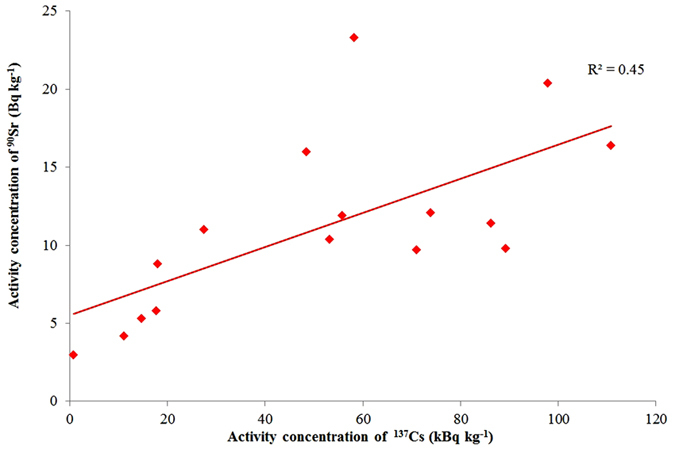
Correlation between 90Sr and 137Cs activity concentration in soil samples collected from the exclusion zone of FDNPP in 2013 (n = 16).